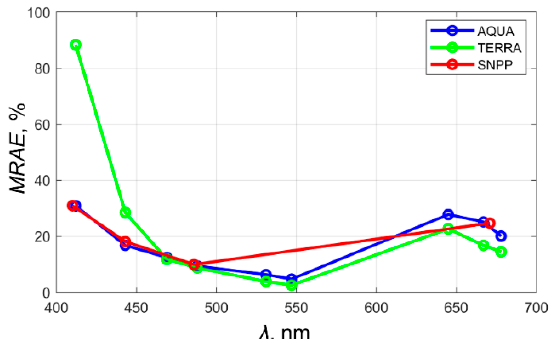
Figure 3. Quality analysis of the atmosphere correction of satellite data. Spectral distribution of MRAE of the determination of satellite band ratio index R OC 2 ( λ ) relative to reference ship-based measurements.